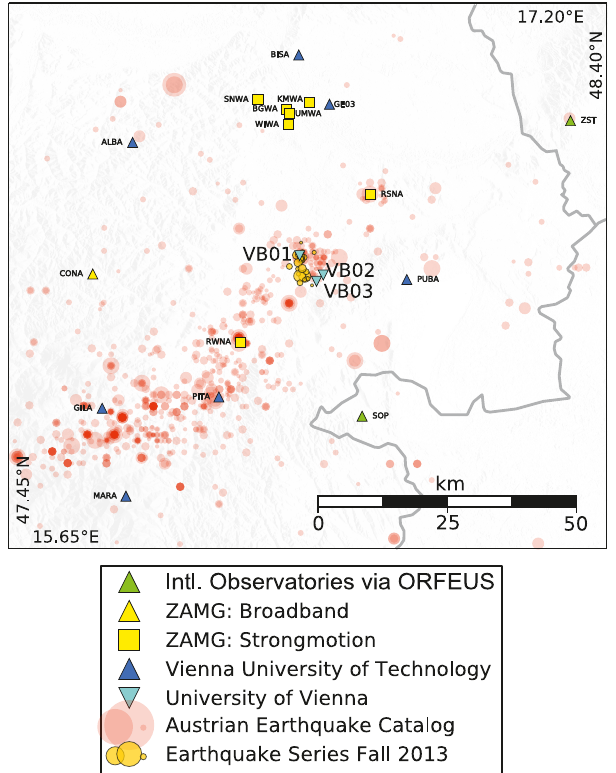
Figure 1. Local station networks and earthquake distribution.